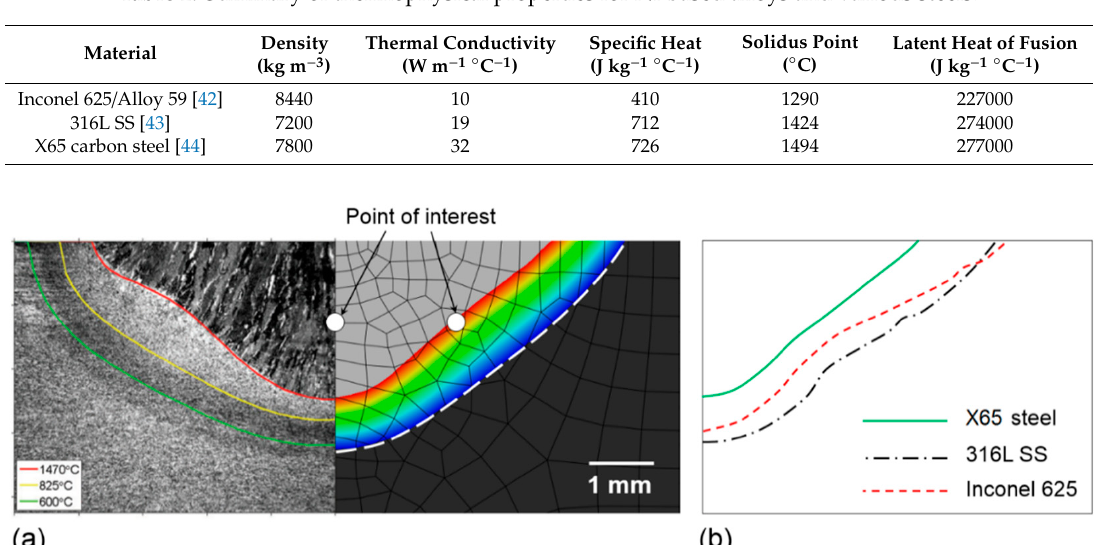
Table 2. Summary of thermophysical properties for Ni-based alloys and various steels.